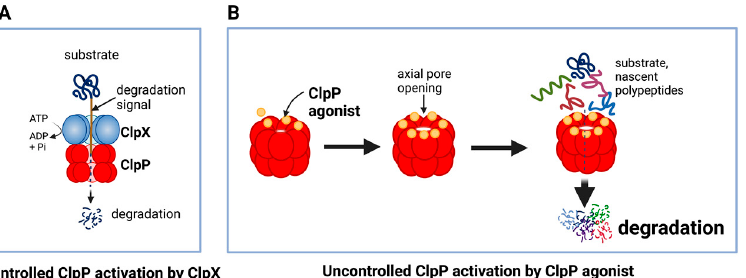
Figure 6. Controlled and uncontrolled proteolysis by ClpP. ( A ) In controlled proteolysis, target substrates are specifically recognized and unfolded by ClpX. The unfolded substrate is transferred into the barrel-like chamber of the ClpP, and proteolysis is carried out by active proteases at the inner surface of the chamber. ( B ) Uncontrolled proteolysis triggered by binding of ClpP agonists to ClpP. Binding of ClpP agonists (yellow spheres) to ClpP subunits displaces ClpX and triggers an opening of the entrance pore of the ClpP barrel, leading to unregulated degradation of nascent polypeptides and unfolded proteins. This uncontrolled ClpP activation does not require ClpX. This figure was generated by BioRender.com (20 January 2023).